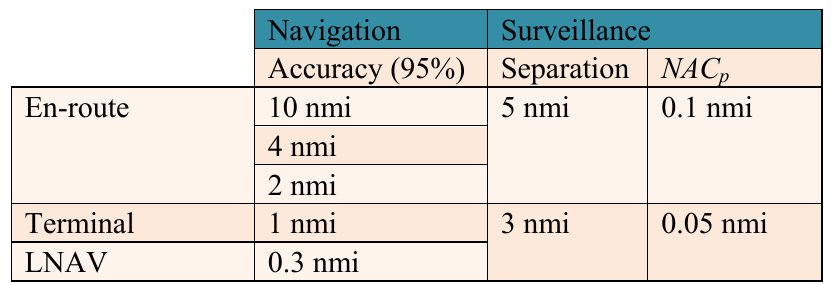
Table 1. Required performance for